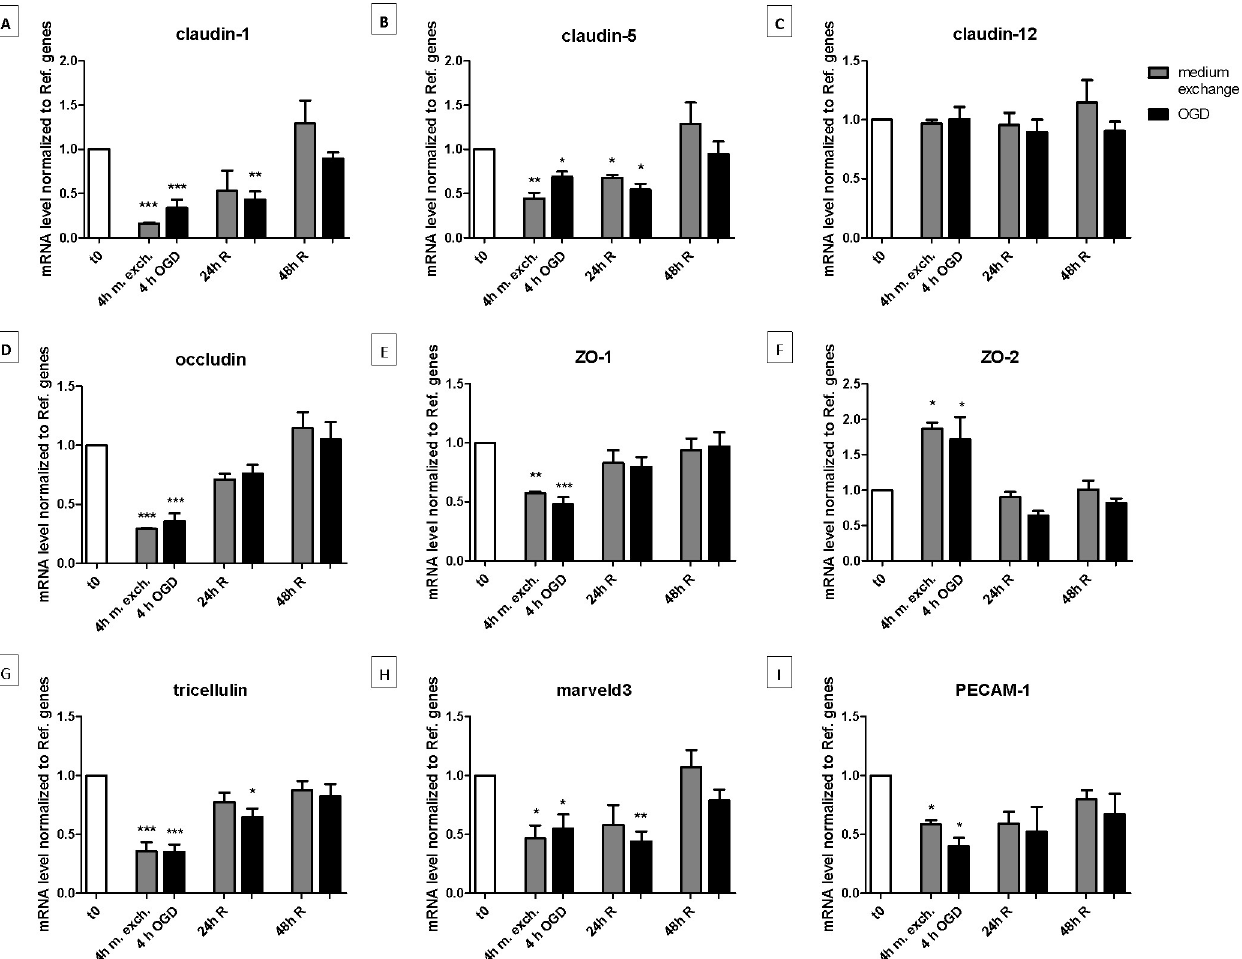
Fig 2. Transcript levels of selected junction proteins in endothelial cells co-cultured with astrocytes before, during and after oxygen-glucose deprivation (OGD) treatment or medium exchange. Endothelial cells which had undergone OGD (black bars) or medium exchange (gray bars) were collected for mRNA isolation. After the reverse transcription of the mRNA, the resultant cDNA was quantified by RT-qPCR using primers specifically designed for bovine. The mRNA amounts of claudin-1 (A), claudin-5 (B), claudin-12 (C), occludin (D), ZO-1 (E), ZO-2 (F), tricellulin (G), marveld3 (H) and PECAM-1 (I) were normalized to reference genes (for calculation see “Materials and methods” section). Bar graphs represent means and error bars are +SEM. The white bars show the values at t0, the gray bars show the cells subjected to medium exchange, while the black bars show the OGD treated cells. Columns were compared to t0 using one-way ANOVA and Dunnett’s multiple comparison post-test. � : p < 0.05, �� : p < 0.01, ��� : p < 0.001. Each pair of columns were compared using one-way ANOVA with Bonferroni’s post-test.